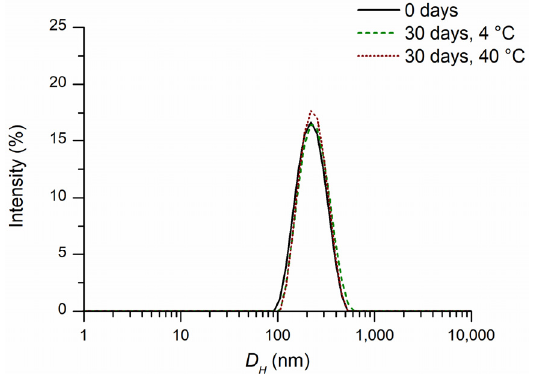
Figure 2. Intensity weighted particle hydrodynamic diameter ( D H , nm) distribution of FEO-NC sus- pension: freshly prepared, stored at 4 and 40 °C for 30 days.